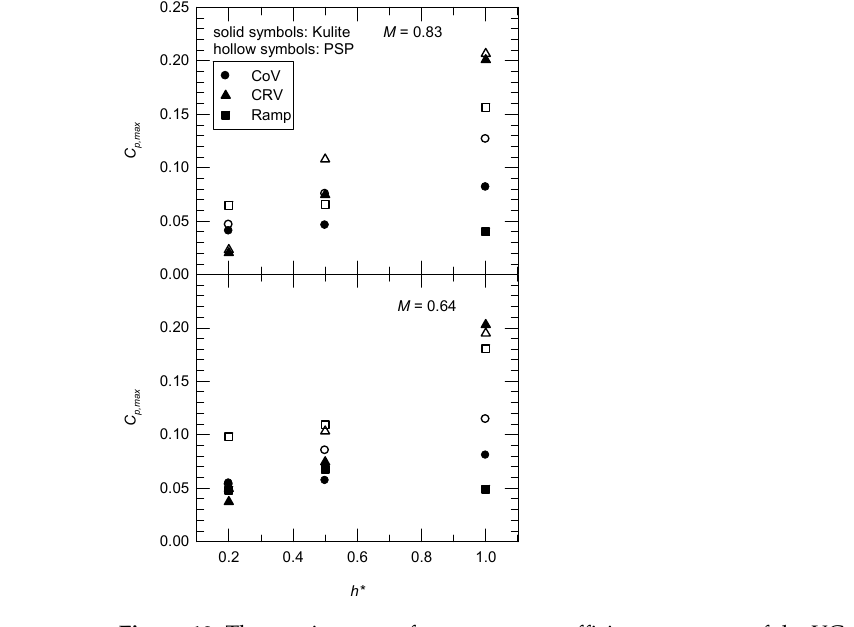
Figure 10. The maximum surface pressure coefficient upstream of the VGs.